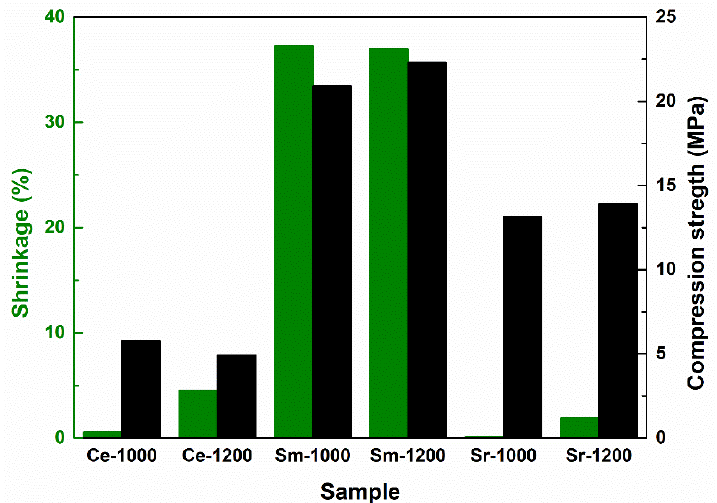
Figure 8. Shrinkage and compression strength for the sintered scaffolds.